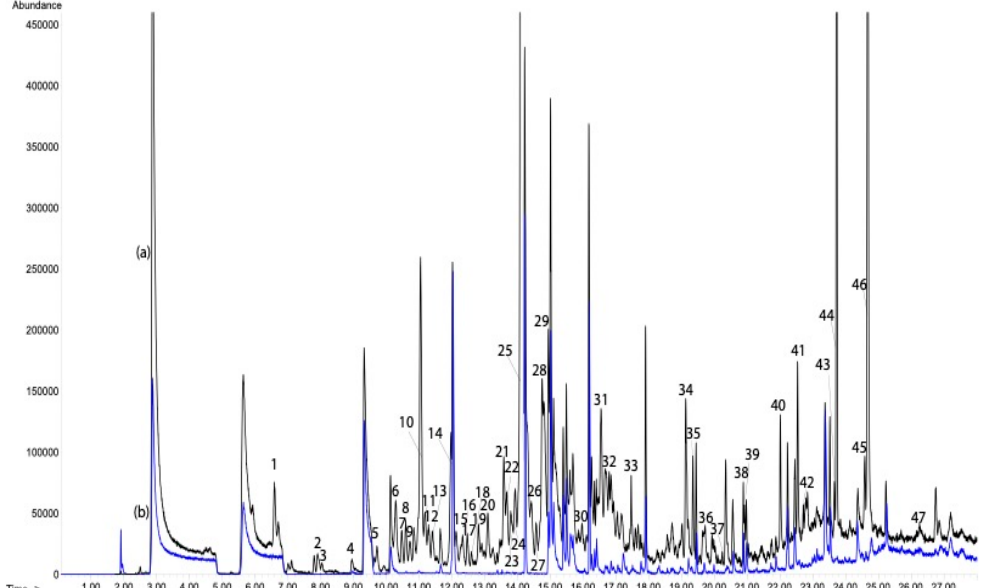
Figure 1. Chromatogram of (a) AL sample—leaves mixture from all collected plants from Albarracín (black line) compared to (b) blank (empty vial) (blue line) obtained by HS-SPME-GC-MS. Legend has been presented in Table 2. Table 2. Legend for Figure 1 presenting list of compounds numbered on the chromatogram.